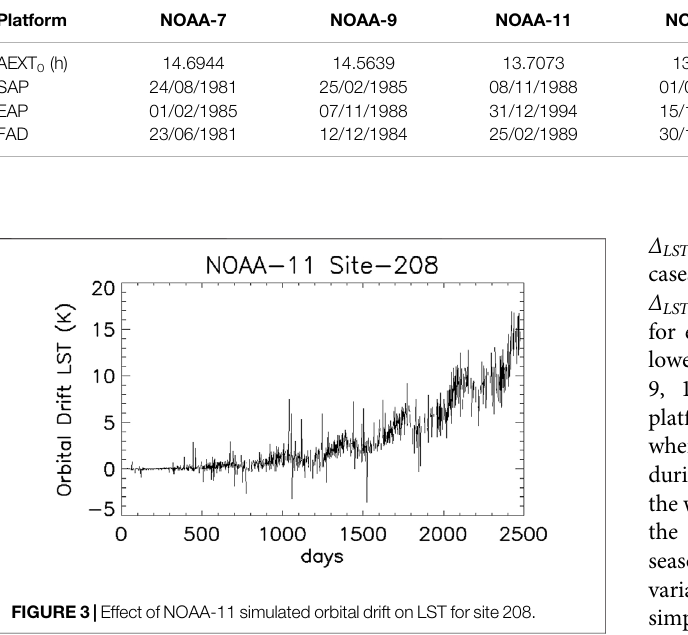
Frontiers in Remote Sensing |